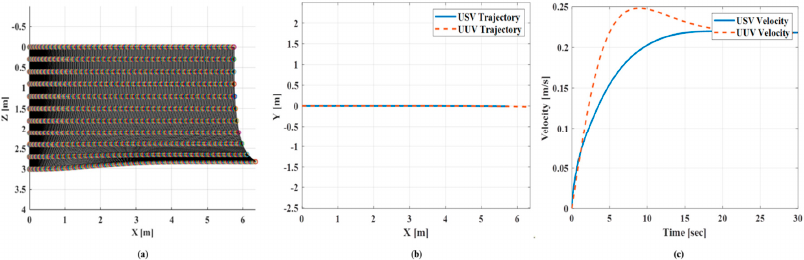
Figure 19. Simulation results of dynamic behavior of unmanned ocean platform when the USV and UUV velocities are similar: ( a ) X - Z trajectory of the unmanned ocean platform; ( b ) X - Y trajectory of the USV and UUV; ( c ) X-axis velocity of the USV and UUV.